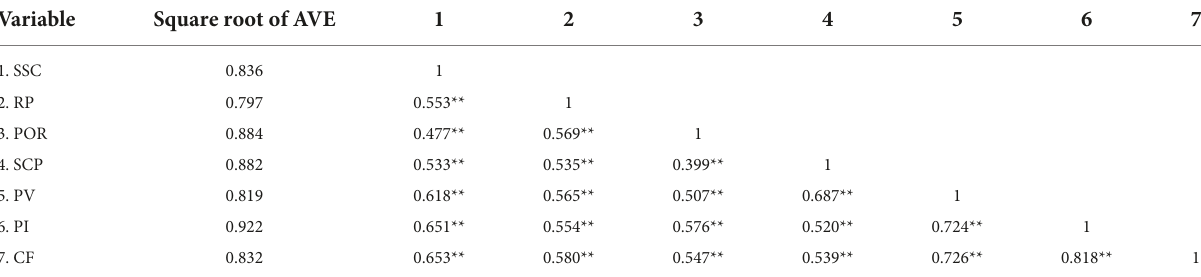
TABLE 3 Construct discriminant validity.